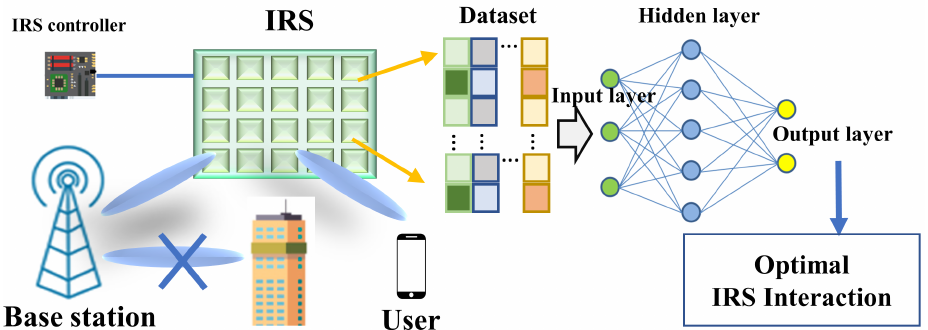
Figure 8. SL-based IRS-enhanced communication